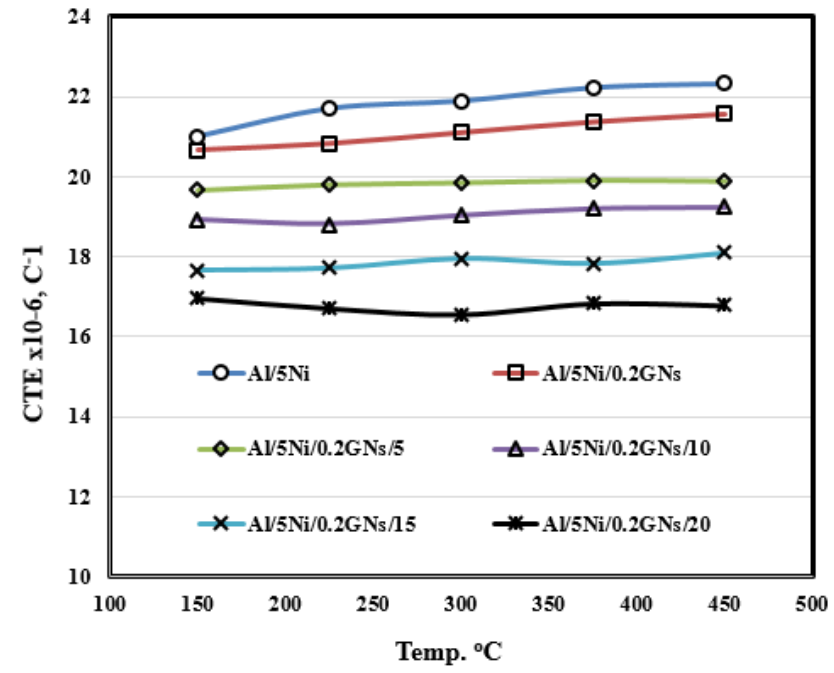
Figure 8. Coefficient of thermal expansion (CTE) of samples fabricated at 600 °C.